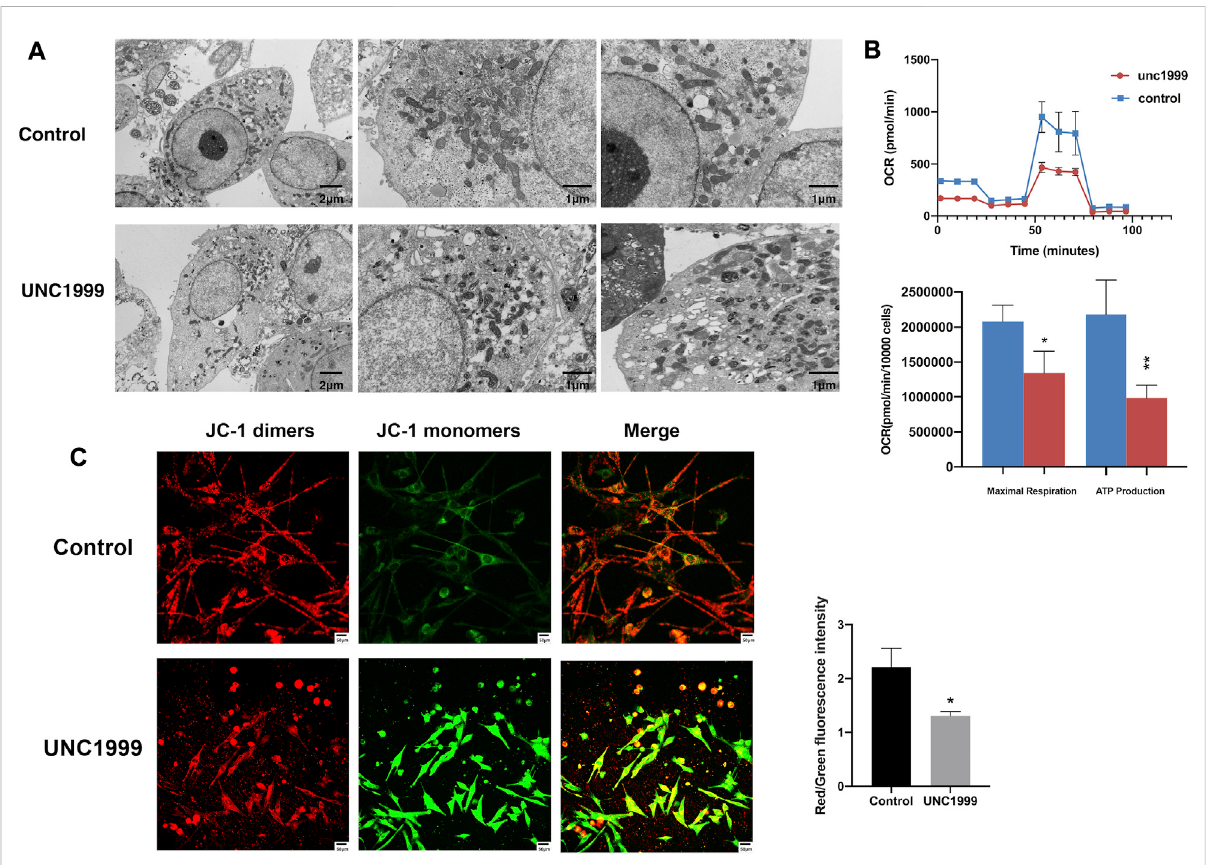
FIGURE 6 UNC1999 causedstructuraldamageanddysfunction inmitochondria. (A) Transmissionelectron microscopy imageshowstheultrastructure of OMM1 cells treated with UNC1999 for 48 h. The volume of mitochondria decreased, the outer mitochondrial membrane was disrupted, the mitochondrialridgedecreasedorwasabsent,andmembranedensityincertainareaswasincreasedintheUNC1999group. (B) Oxygenconsumption rate (OCR) curves and Seahorse XF analyzer measurements of mitochondrial respiration of OMM1 cells. After 48 h treatment of